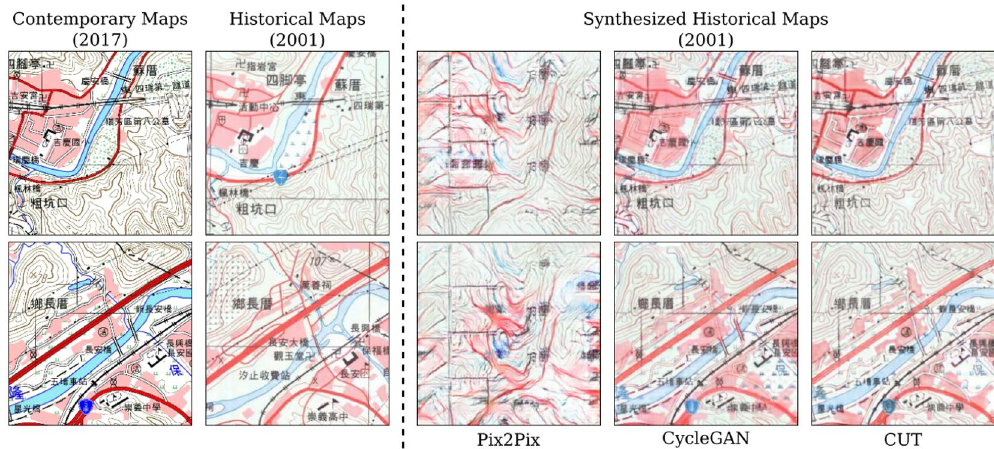
Figure 8. Examples of the synthesized historical maps generated by Pix2Pix 29 , CycleGAN 30 , and CUT 21 . Although the map tiles produced by Pix2Pix are obviously broken, CycleGAN and CUT transferred the contemporary map tiles to the historical style successfully. If we focus on the bridge symbols in the synthesized tiles, we can find that the tiles made by CUT are much more like the historical map than those made by CycleGAN. † The maps in this figure are provided by Taiwan Historical Maps System (https:// gis. sinica. edu. tw/ tiles erver/) with